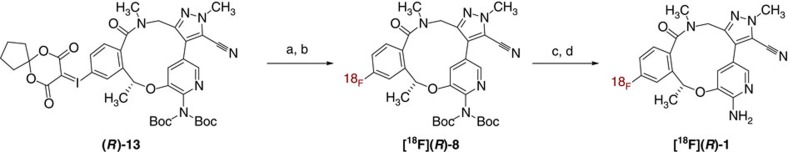
Synthesis of [18F](R)-1 via an iodonium ylide precursor.Reagents and conditions: (a) 2 mg iodonium ylide (R)-13 in 400 μl of DMF (anhydrous), azeotropically dried [18F]Et4NF, 80 °C, 10 min.; (b) HPLC purification followed by C18 SPE isolation; (c) 4 M HCl, 90 °C, 10 min; (d) neutralization to pH 5 using NaOH and NaOAc, reformulation on HLB SPE.